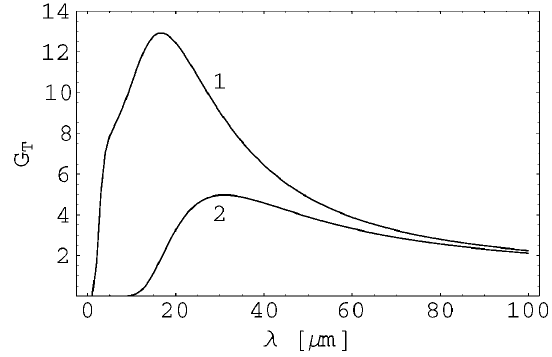
FIG. 5. Total amplification factor G T of BC1 and BC2 as a function of the modulation wavelength at the entrance of BC2 (1) without the wiggler; (2) with the